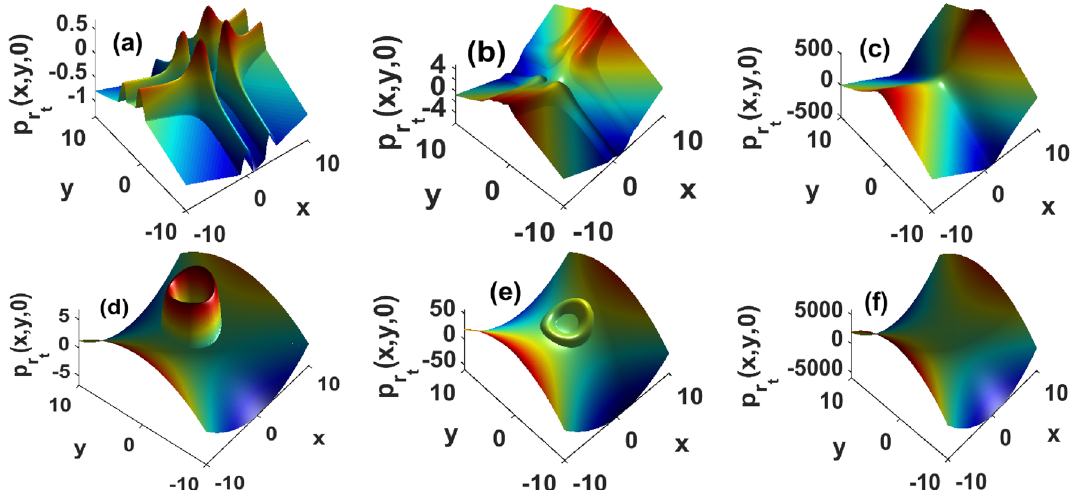
Figure 2. Reduction of instability domains in presence of a strong incompressible velocity field. Top panels are obtained by injecting two-dimensional hyperbolic secant distribution, and bottom panels are recovered by using a two-dimensional Gaussian profile. Left panels τ x = τ y = 10 2 , middle τ x = τ y = 1 and right panels τ x = τ y = 0.01 . Other parameters as in Fig. 1.